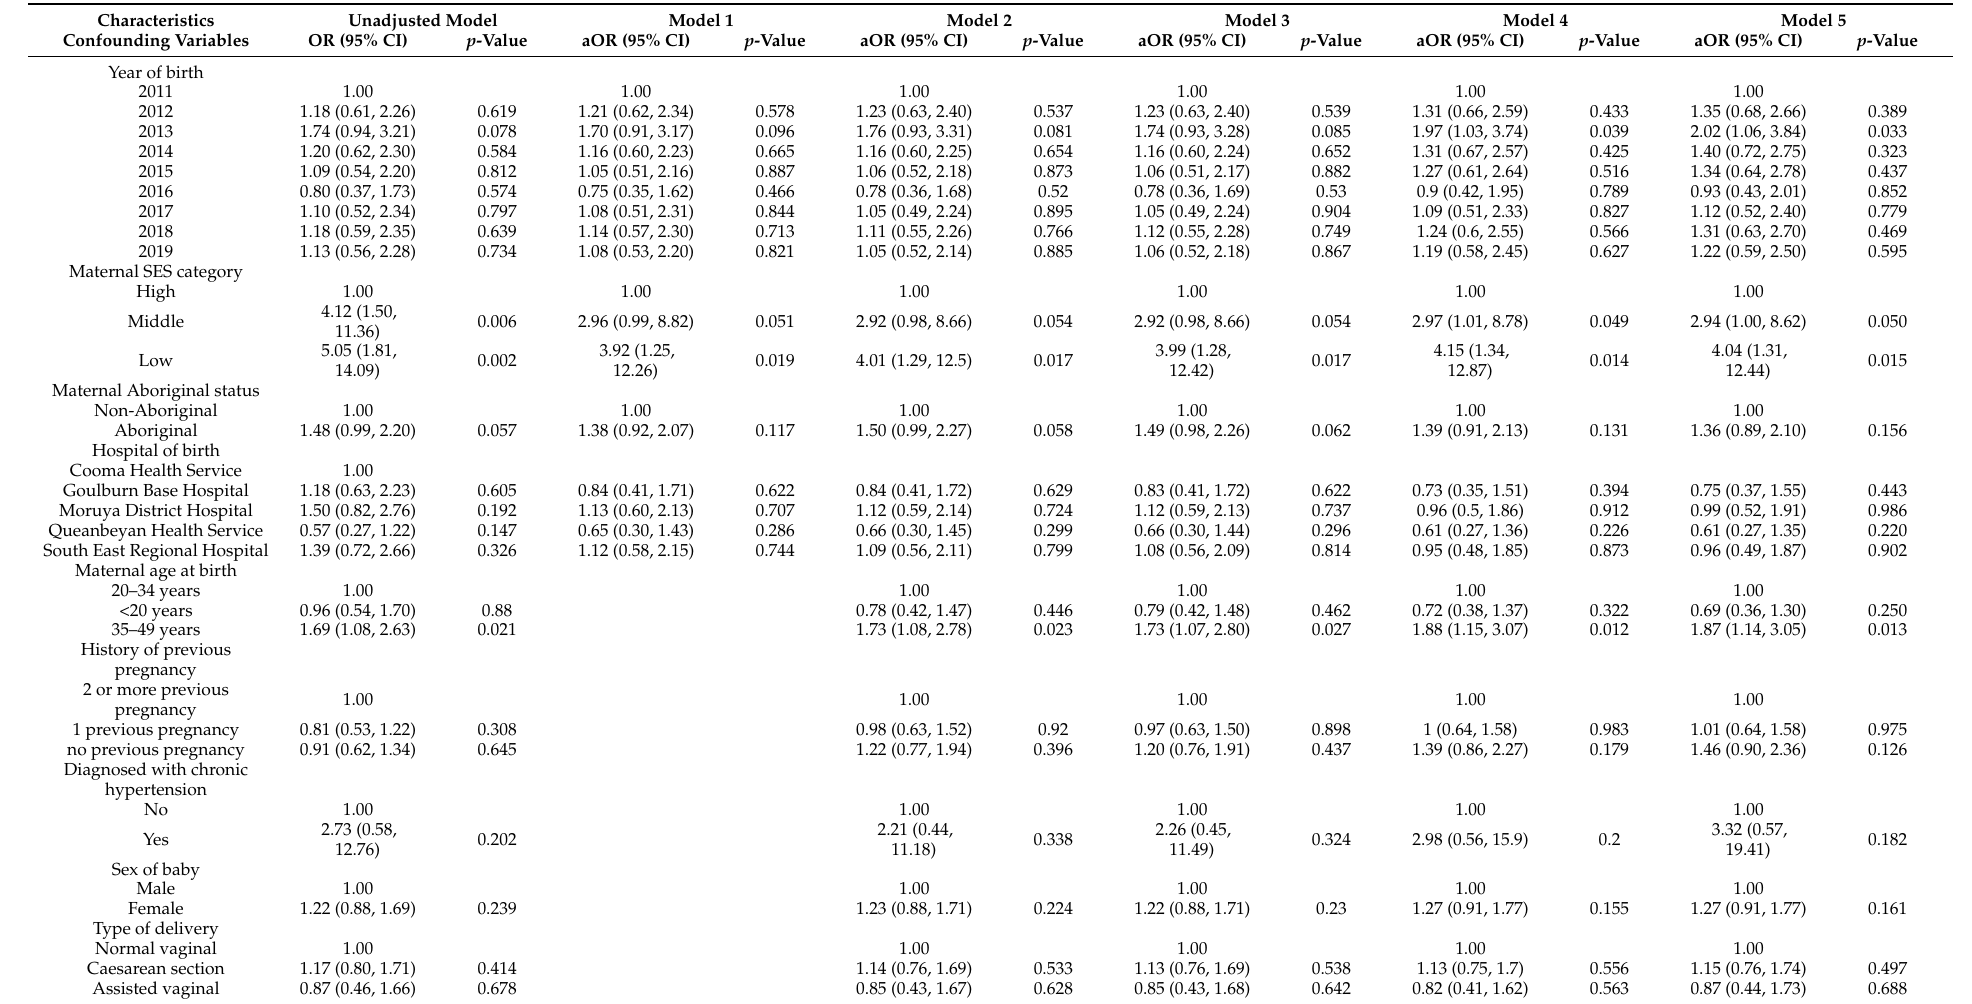
Table 2. Unadjusted and adjusted odds ratio (aOR) and 95% confidence interval (CI) for study variables and low birth weight (LBW) in SNSWLHD